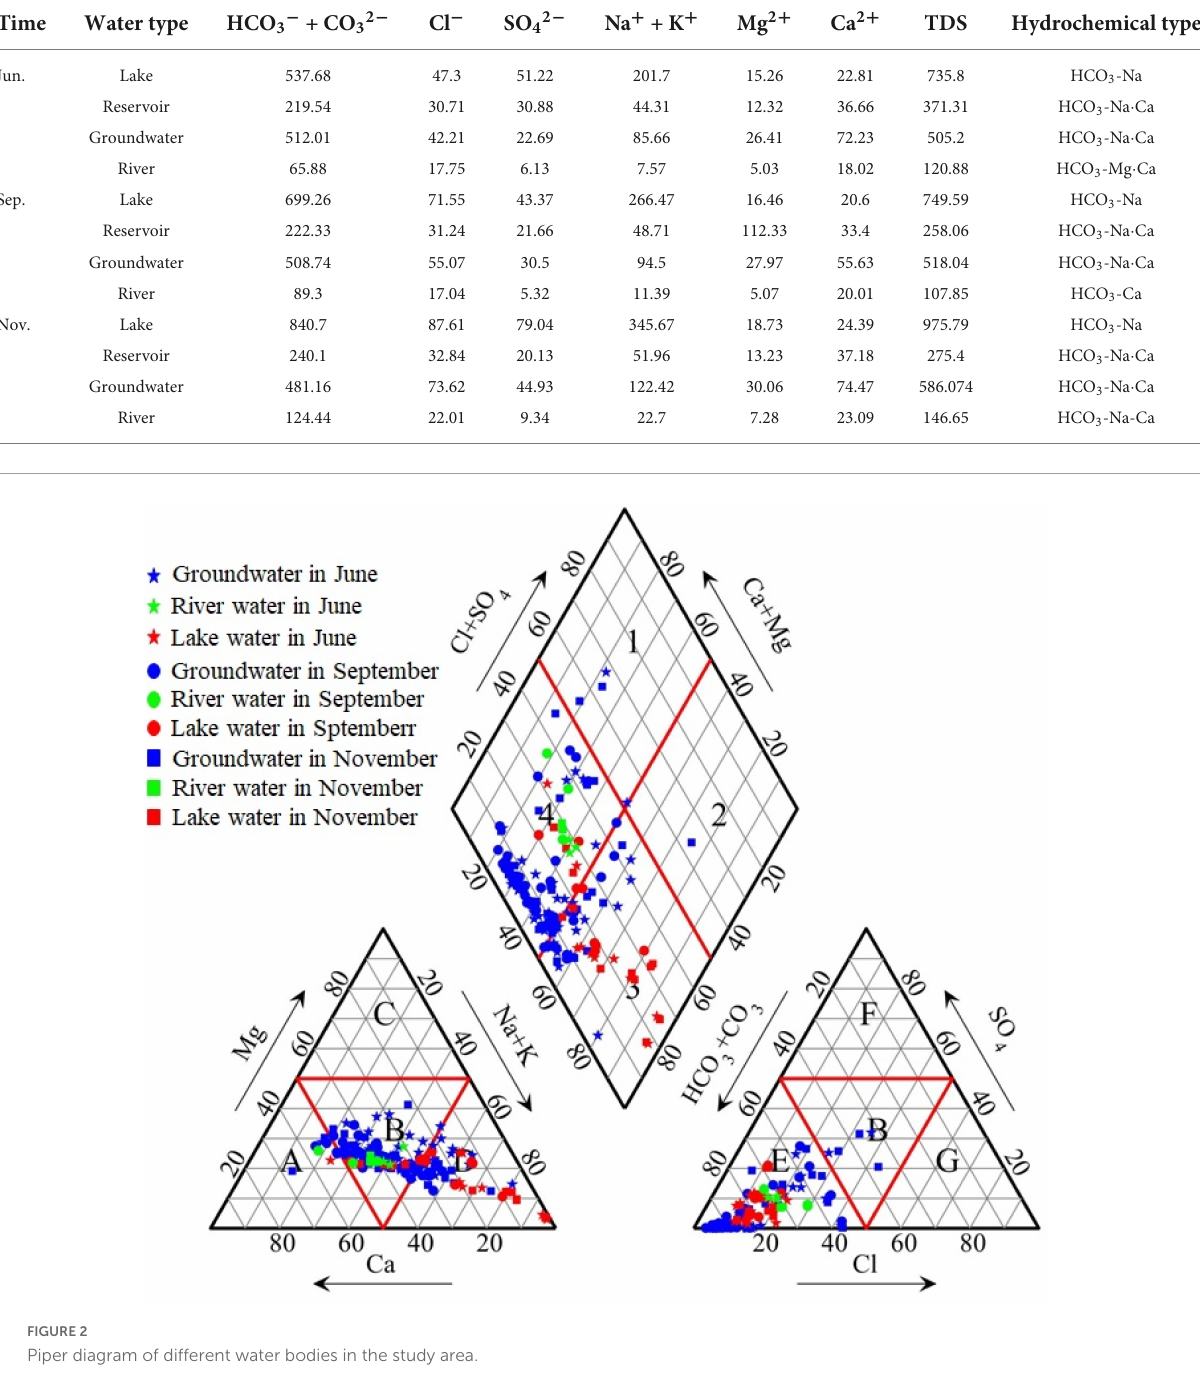
of precipitation from the surface accounts for a large proportion of the local water vapor source. The average values of δ 2 H and δ 18 O in the groundwater, lake water, and river water were – 76.3, –9.1, and –50.8% and –4.7, –55.5, and –5.3%, respectively ( Figure 3 ). The isotope values of groundwater, lake water, and river water in the MNNR were distributed along the LMWL,